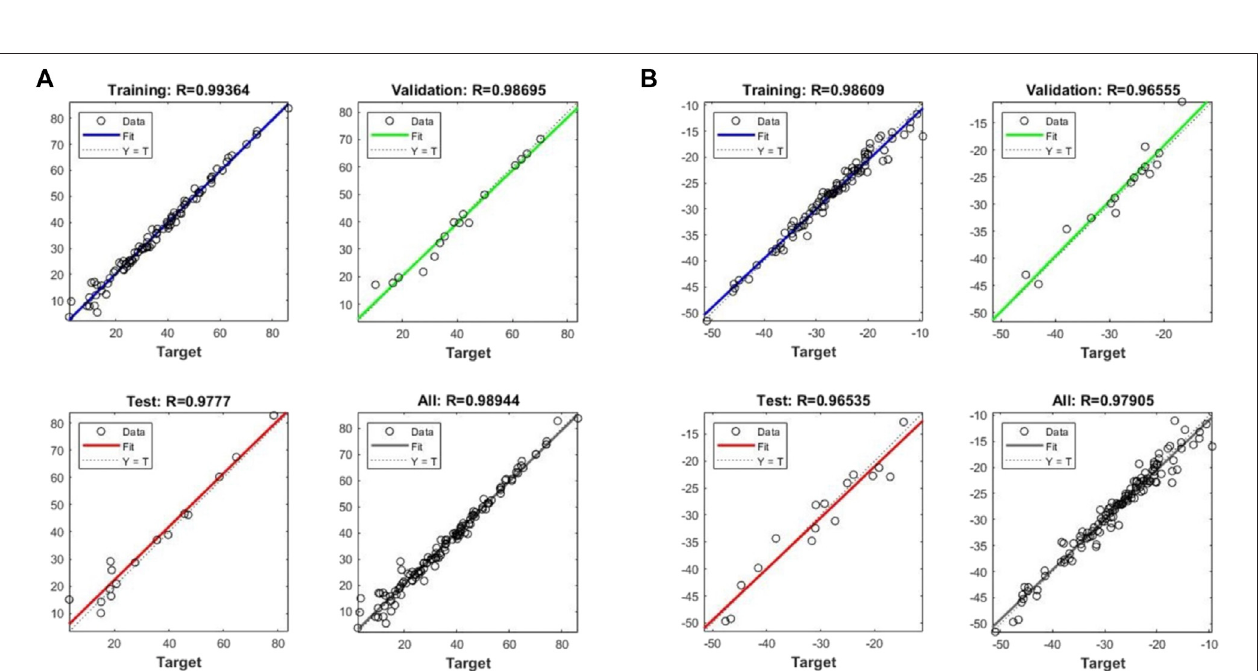
FIGURE 6 | Measures of the R-squared for train, validation, and entire data for (A) Re fl ection coef fi cient and (B) Q-factor models.